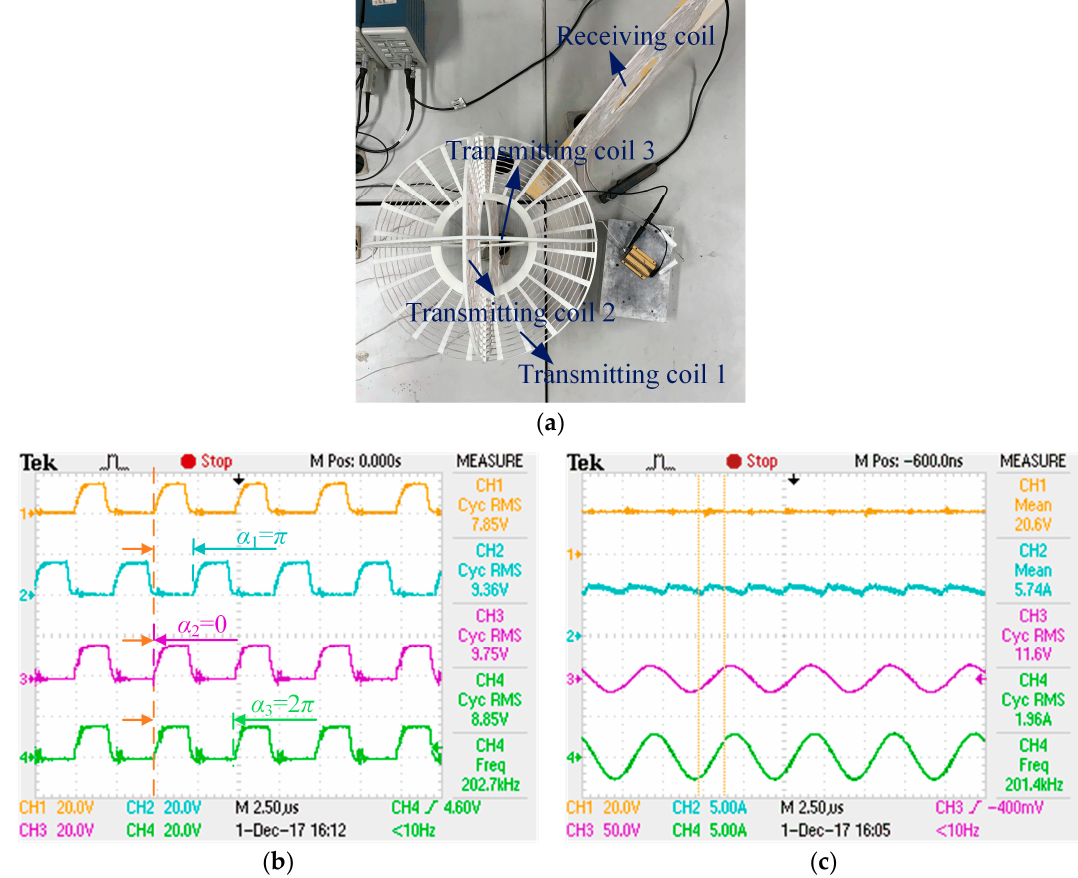
Figure 19. Practical measurements in the conditions Θ = 90°, Φ = 45°, θ ′ = 90°, φ ′ = 0°, ψ ′ = 45° and d = 0.4 m. ( a ) Locations and postures of system coils; ( b ) phase-shifted drive pulses; ( c ) input/output voltage and current waveforms.